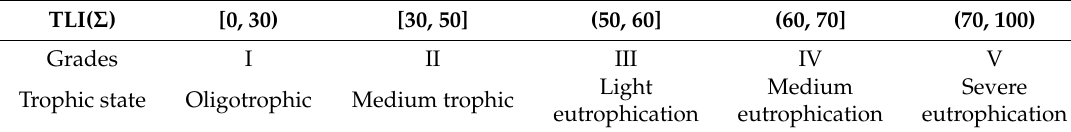
Table 1. Classification of eutrophication